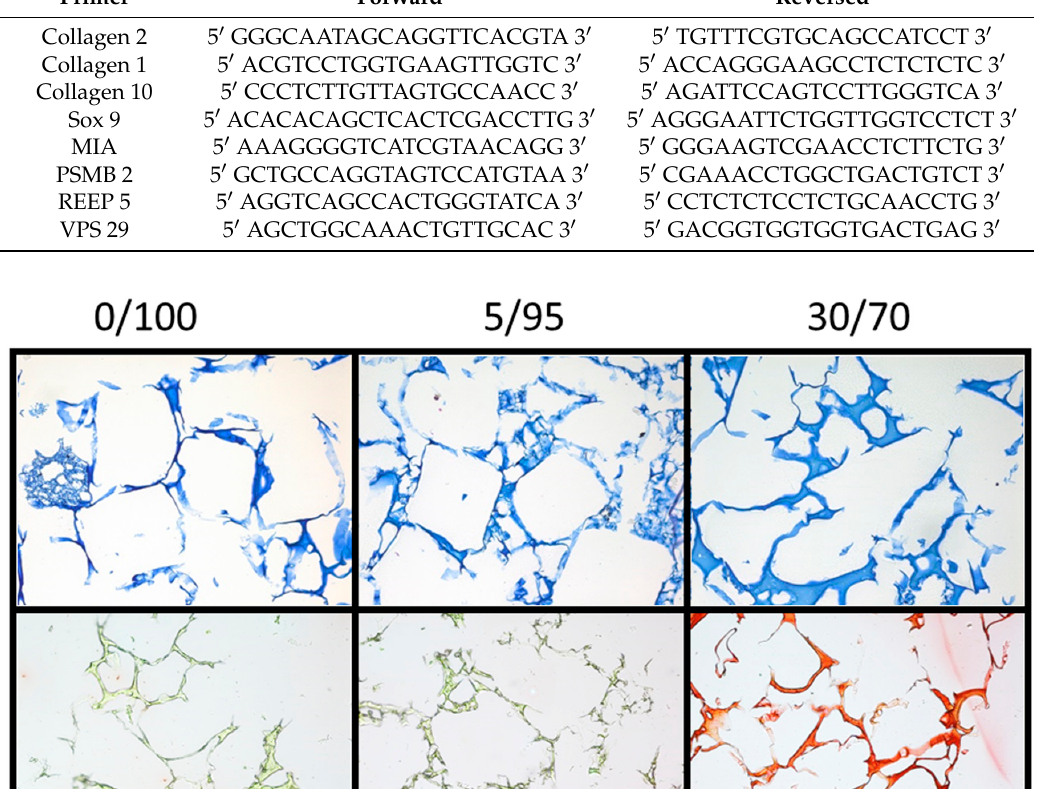
Table A1. PCR-Primers and sequences.